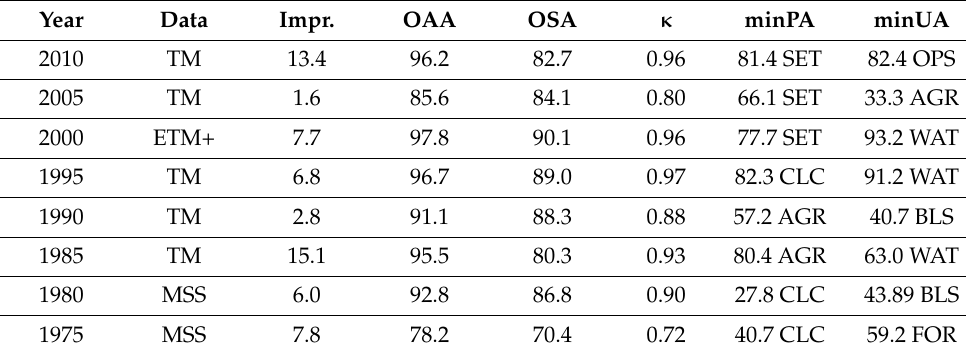
Table 2. Accuracy values of land-use maps. Impr.: Improvement over standard approach (SVM on spectral data), OAA: Overall Accuracy, OSA: Overall Accuracy of standard approach, κ : Kappa coeff., minPA: lowest producer accuracy yielded (with class), minUA: lowest user accuracy yielder (with class). Class abbreviations, see Table